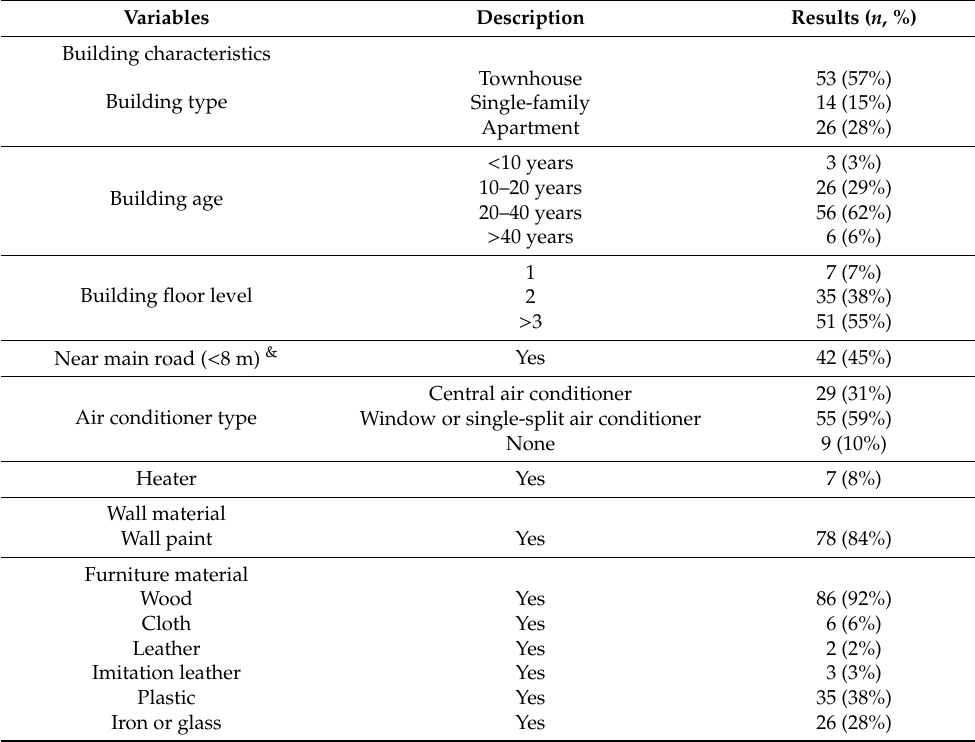
Table 1. Summary of building characteristics and materials of 93 studied households.